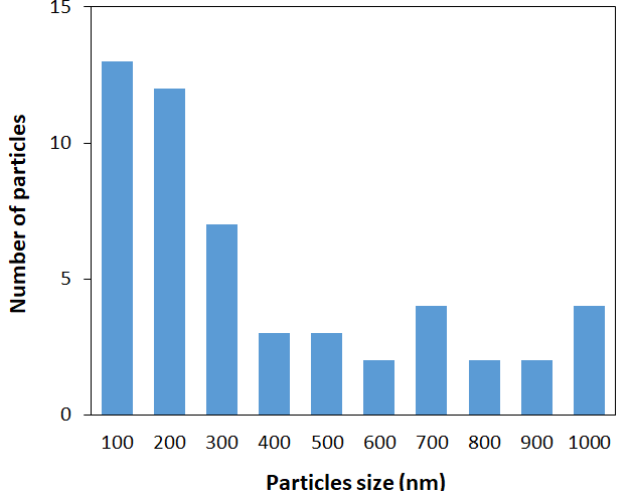
Fig. 10. Particles size distribution analysis of silver nanoparticles produced at concentration of AgNO 3 solution 0.1 M for sample A (based on Fig.